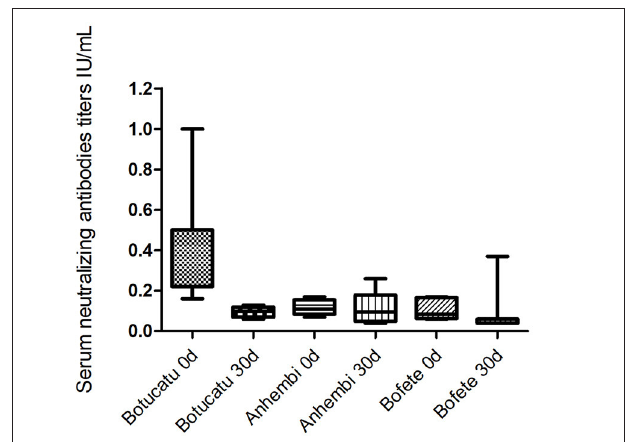
FIGURE 2 | Geometric mean titers (GMT) of virus-neutralizing antibodies in the bats from the studied municipalities. Municipalities with different scenarios evaluated at 0 and 30